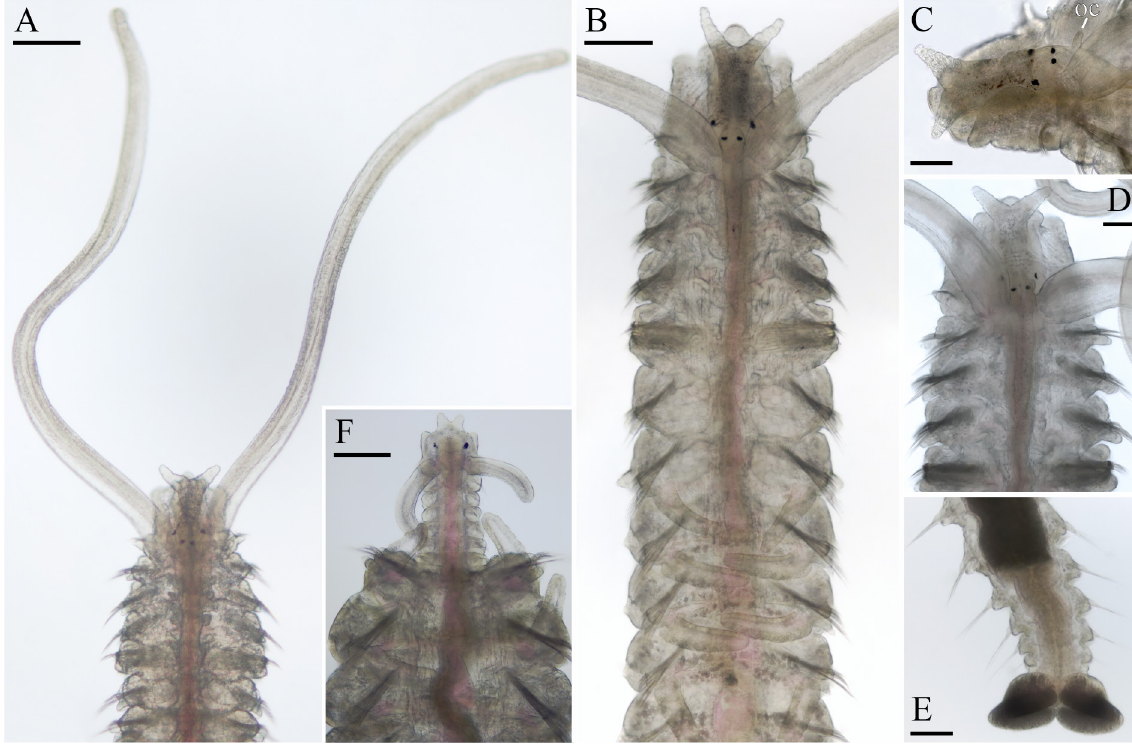
Fig. 4. Adult morphology of Pseudopolydora antennata (Claparède, 1868) (live individuals). A . MIMB 40895. B–C, E . MIMB 40897. D . MIMB 40899. F . MIMB 40896. A–B , D . Anterior ends, dorsal view. C . Anterior end, left lateral view. E . Posterior end, dorsal view. F . Middle stalk chaetigers regenerating seven anterior chaetigers, dorsal view. Abbreviations: oc = occipital antenna. Scale bars: A–B, F = 200 µm; C–E = 10